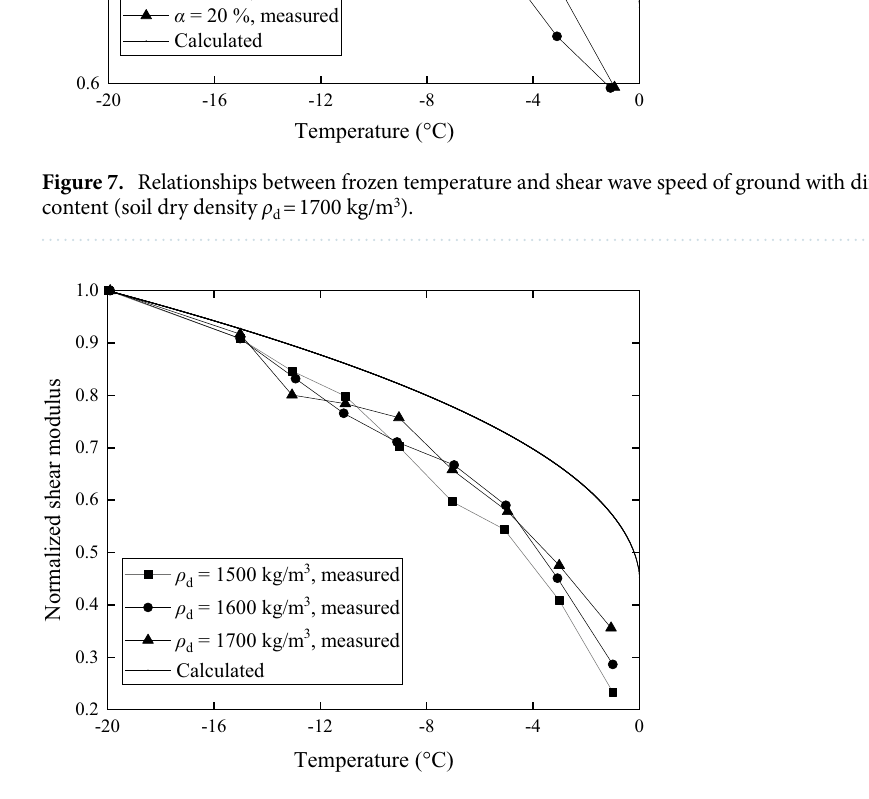
Figure 8. Relationships between frozen temperature and shear modulus of ground with different soil dry density (soil water content α =